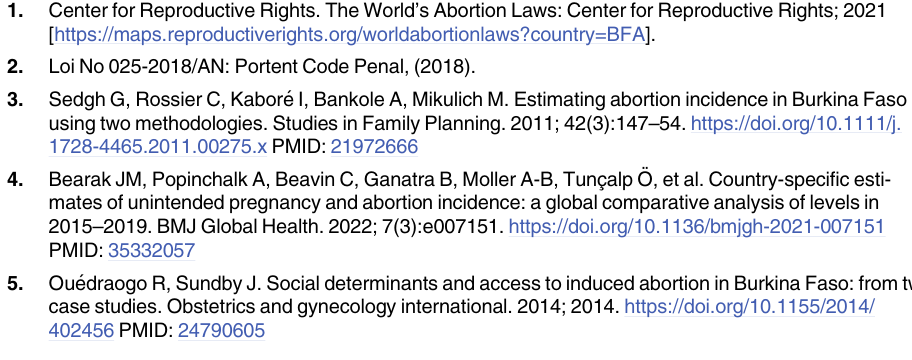
S1 Table. Characteristics of female respondents aged 15 to 49 overall and by whether they report having at least one close female friend in Burkina Faso. S2 Table. Induced abortion incidence (per 1,000) among female respondents aged 15 to 49 and their closest female friends aged 15 to 49 in Burkina Faso by background characteris- tics. S3 Table. Percent of induced abortions that were unsafe among female respondents aged 15 to 49 and their closest female friends aged 15 to 49 in Burkina Faso by background char-